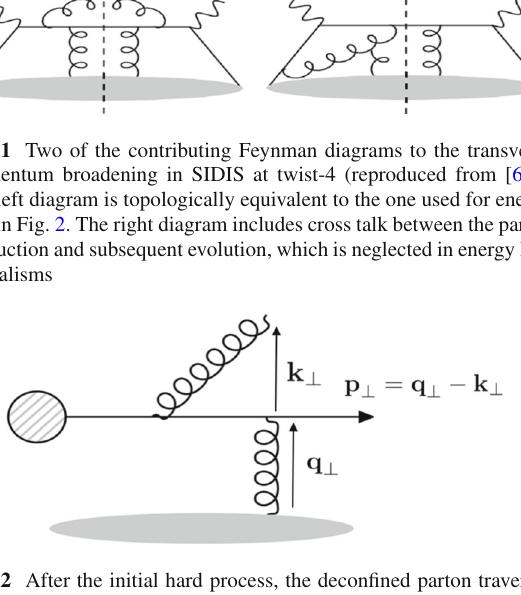
Fig. 2 After the initial hard process, the deconfined parton traverses the medium. Transverse momentum can be transferred to this parton via collisions with the medium ( q ⊥ ) or the stimulated emission of soft gluons ( k ⊥